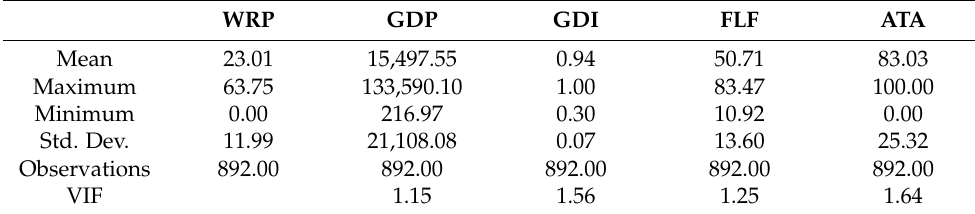
Table 2. Summary Statistics.